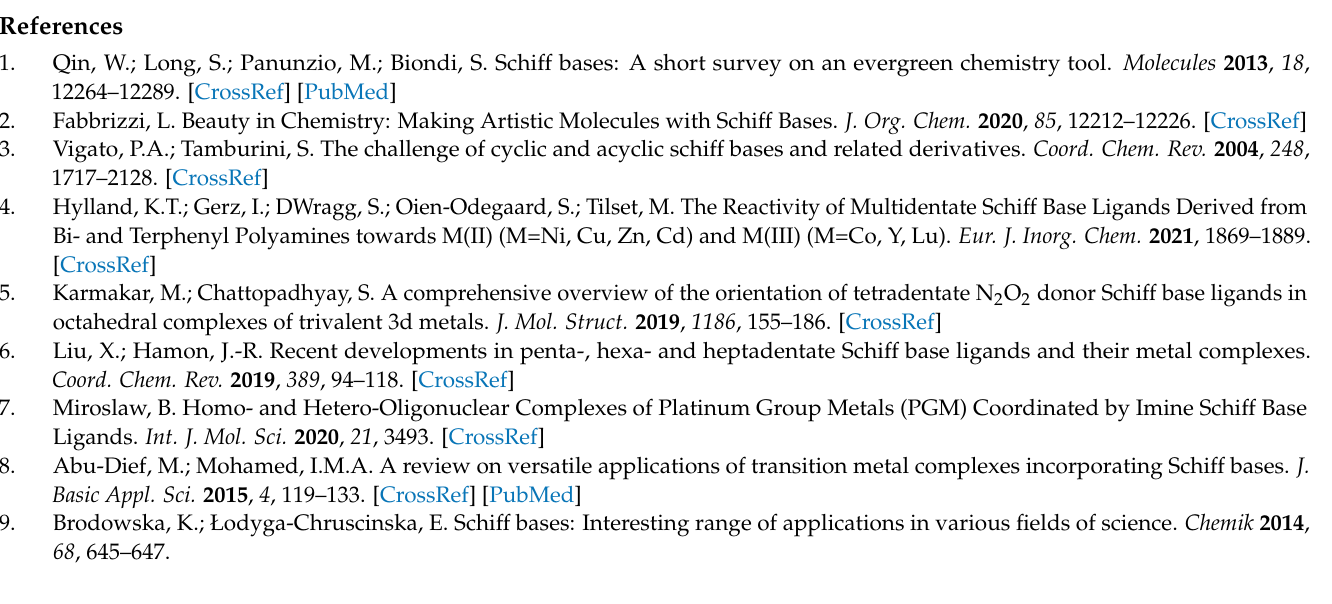
labelling schemes for complex 7 used for NMR assignments, Figure S1: FT-IR spectrum of 8 recorded in KBr disk, Figure S2: 1 H NMR spectrum of complex 7 , recorded at 400 MHz in CD 2 Cl 2 , Figure S3: 1 H NMR spectrum of complex 8 , recorded at 400 MHz in CD 2 Cl 2 , Figure S4: Molecular structure of trans -PdI 2 (PPh 3 ) 2 ( 9 ), Figure S5: Crystal packing of 4 expanded through a-axis by H-bond interactions, Figure S6: Crystal packing of 5 expanded in the a- and c-axis plane by H-bond interactions, Figure S7: Crystal packing of 6 expanded in the a-axis direction, Figure S8: Crystal packing of 8 expanded in the b-axis through H-bond interactions, Figure S9: The DFT-optimized structures of complexes 4–6 and 8 , Figure S10: The HOMOs and LUMOs of complexes 4–8 , Table S1. UV-vis absorption data for compound 8 and its 4,4’-bipy bridged counterpart. Table S2: bond distances (Å) and angles ( ◦ ) for compounds 4 , 5 , 6 and 8 , Table S3: Hydrogen bond interactions in 4 , 5 and 8 , Table S4.